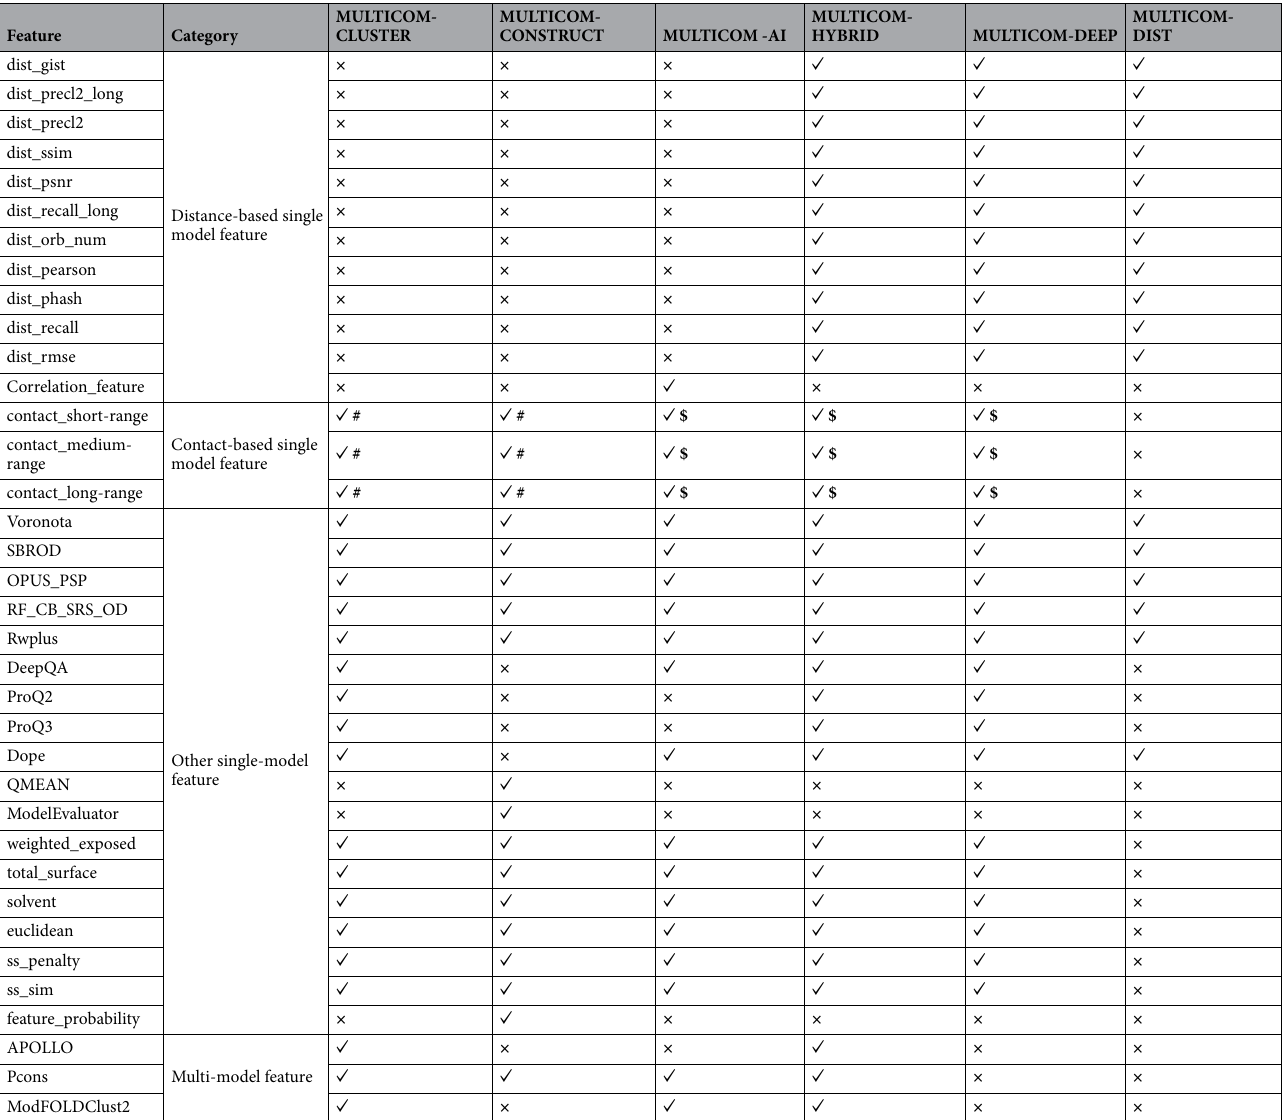
Table 2. Features used by six MULTICOM EMA predictors. The features are divided into four categories: distance-based single-model features, contact-based single-model features, other single-model features, and multi-model features. ✓ : a feature used by a predictor. × : a feature not used by a predictor. #: features based on contacts predicted by DNCON2. $: features based on contacts predicted by